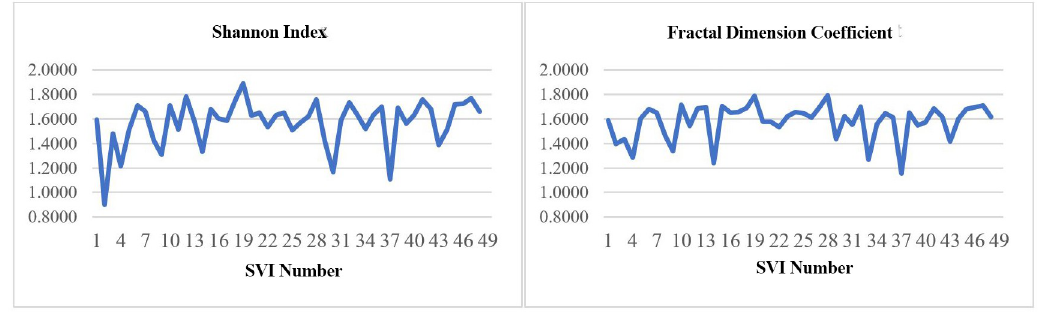
Fig 3. Shannon Diversity Index (SDI) and fractal dimension coefficient variation across the 48